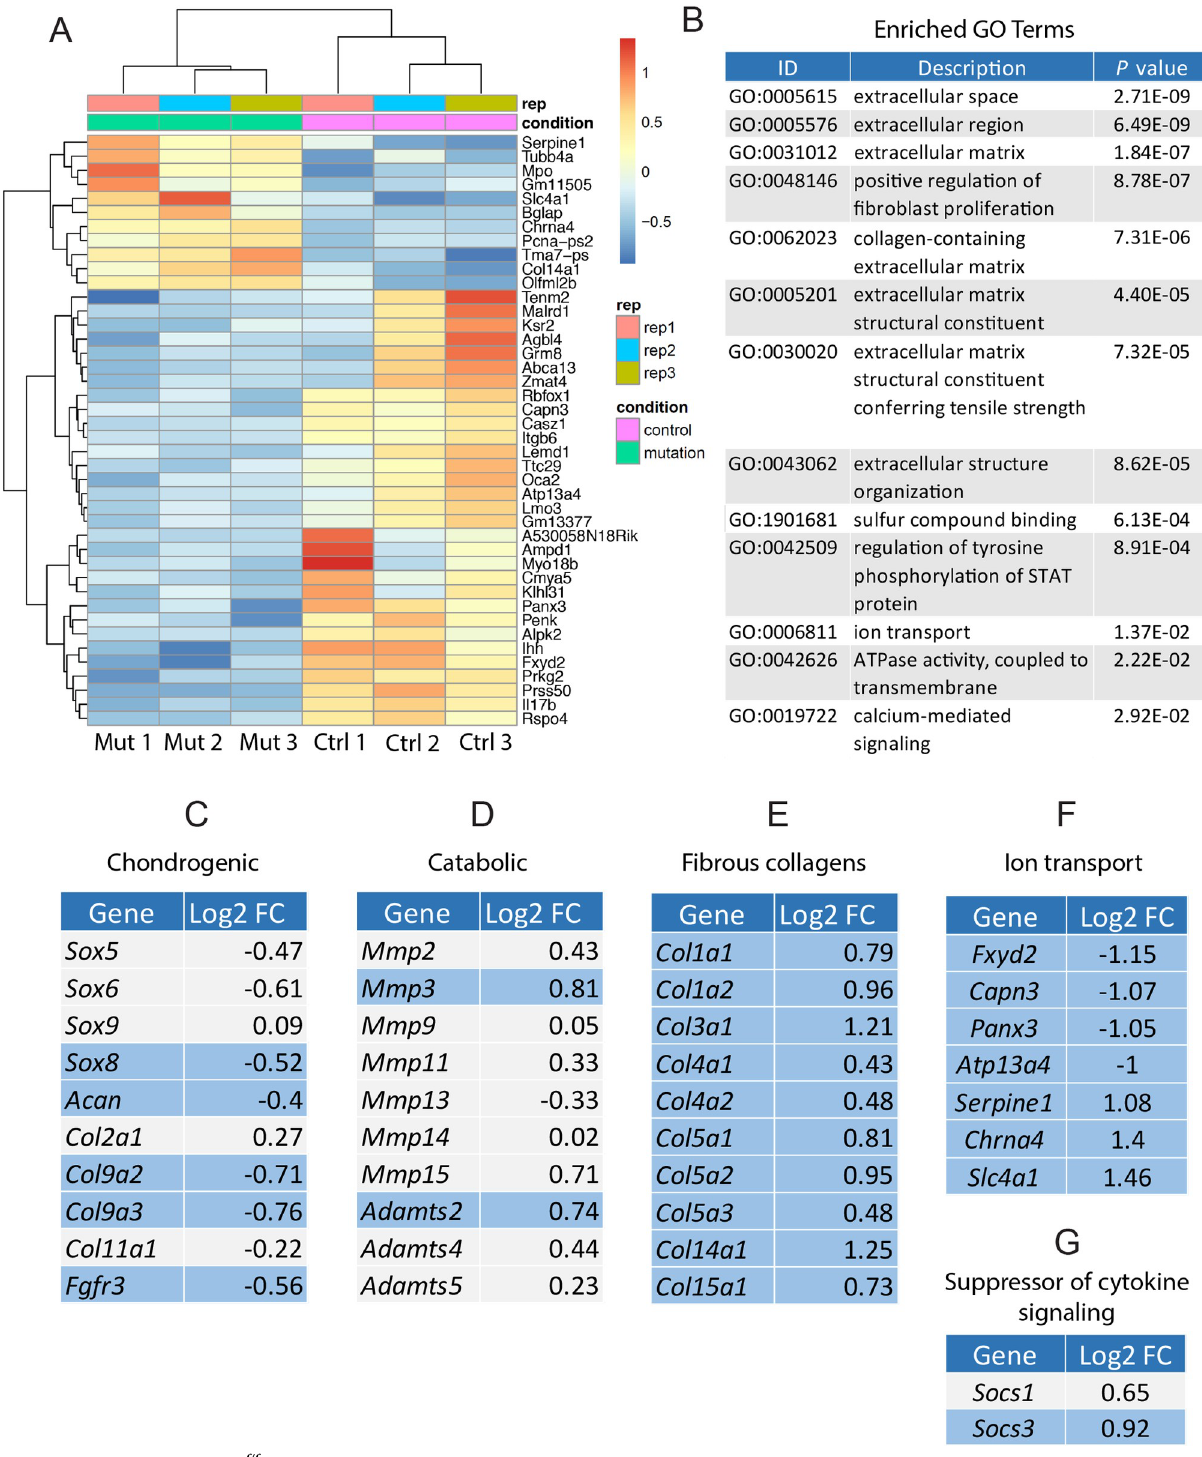
Fig 3. Young Col2Cre;Adgrg6 f/f mutant mice display fibrotic-like changes of gene expression and dysregulation of genes associated with ion transport in the IVD. (A) Heatmap of differentially expressed gene based on RNA-sequencing analysis of IVDs derived from both Col2Cre;Adgrg6 f/f mutant (Mut 1–3) and Cre (-) littermates (Ctrl 1–3) at P20. (B) Gene ontology (GO) analysis revealed a suite of differentially expressed genes important for extracellular matrix organization and ion transport. (C-G) RNA-sequencing analysis revealed mild alterations in some chondrogenic (C) and catabolic (D) gene expression, but significantly induced fibrotic gene expression (E) and dysregulation of genes involved in ion transport (F) in